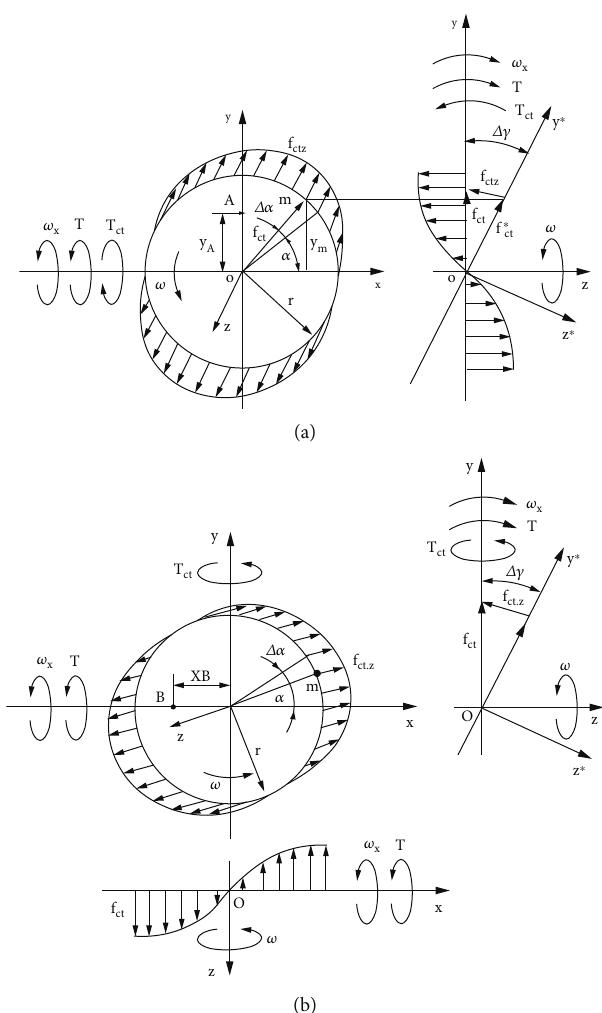
Figure 2: Schematic of acting centrifugal forces, torques, and motions around axis ox (a) and oy (b) of the spinning annulus.